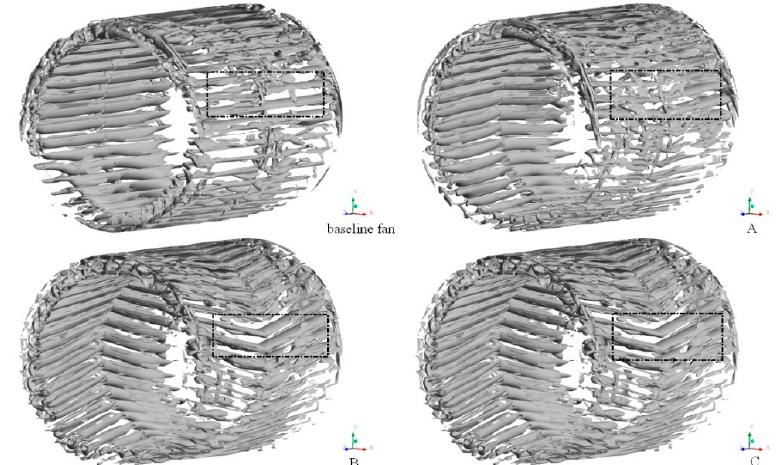
Figure 23. Three-dimensional distribution of vortices in impeller passages at Q / Q n = 1.000: ( A ) model-A; ( B ) model-B; ( C )